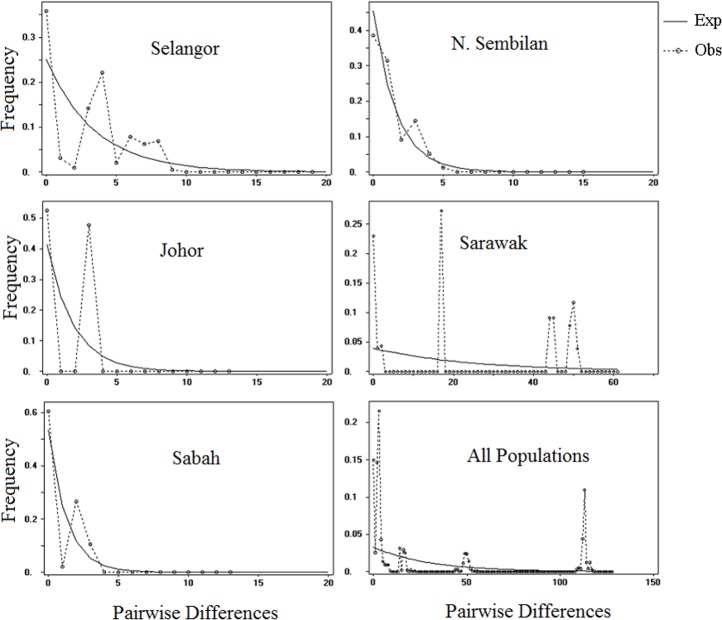
Mismatch distribution of P. canius for different geographical regions and whole population.